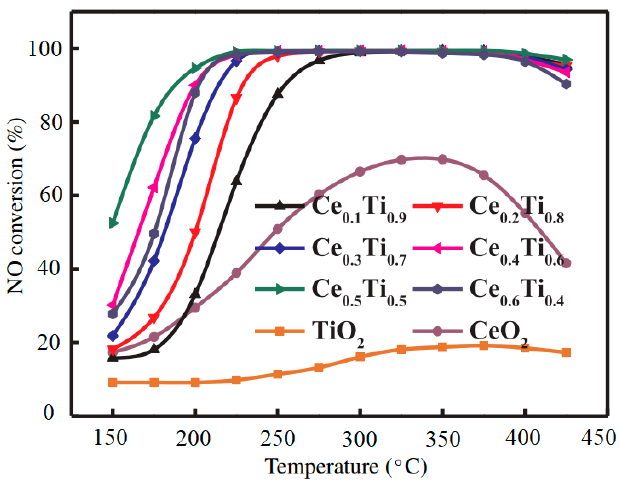
Figure 3. NH 3 -SCR activity of TiO 2 , CeO 2 and Ce a Ti 1 − a catalysts. Conditions: [NH 3 ] = [NO] = 1000 ppm, [O 2 ] = 3 vol.%, N 2 as balance gas, total flow rate = 500 mL·min − 1 [39].